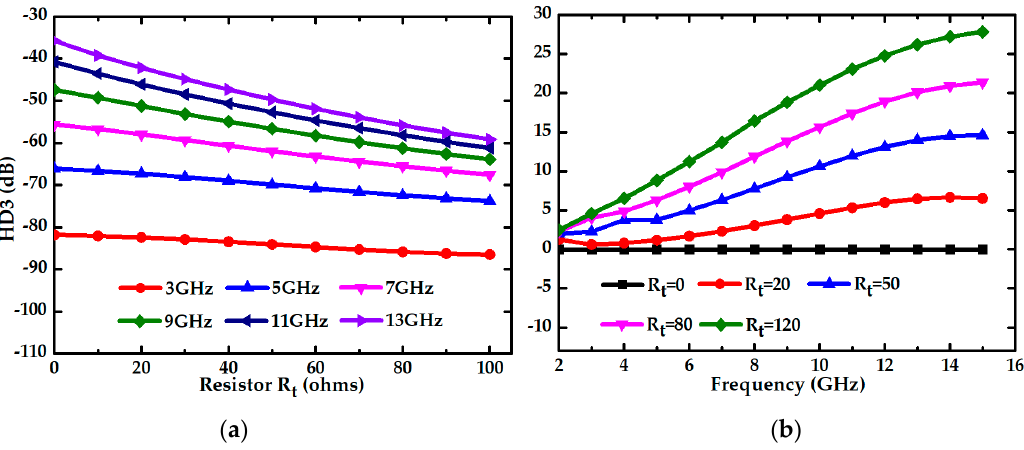
Figure 3. ( a ) Simulated HD3 varies along with Rt at different frequency; ( b ) simulated improvement on HD3 compared with traditional design ( Rt = 0 ).